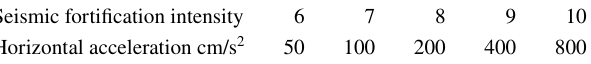
Table 3 Maximal horizontal acceleration at difference intensity Seismic fortification